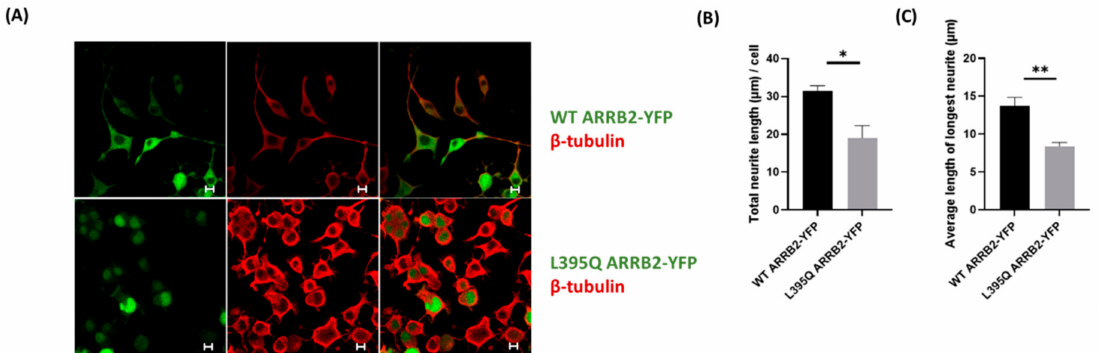
Figure 6. ARRB2 nuclear localization decreased neurite outgrowth in neuro2a cells. ( A ) Representative confocal images of neuro2a cells transfected with WT ARRB2-YFP or L395Q ARRB2-YFP. Neurite branching and length were determined using ß-tubulin immunostaining and quantification by ImageJ ( B , C ). Scale bars, 10 µ m. * p < 0.05; ** p < 0.01 by Mann–Whitney U test. N = 30 images analyzed from three independent experiments.